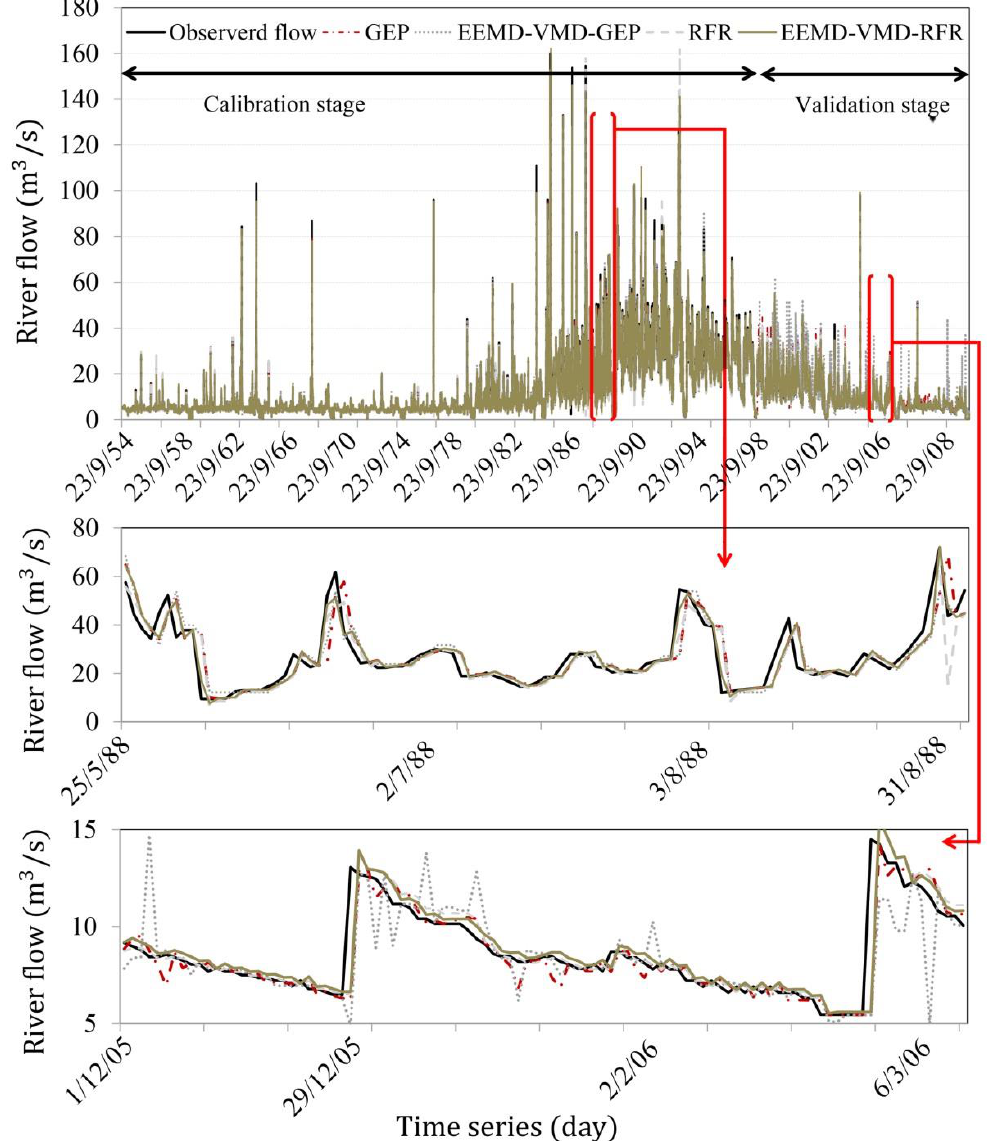
Figure 8. A time-series of observed and forecasted river daily flow of ensemble EEMD-VMD-GEP and EEMD-VMD-RFR models compared with standalone GEP and RFR models for the calibration and validation stages at the Siira station.